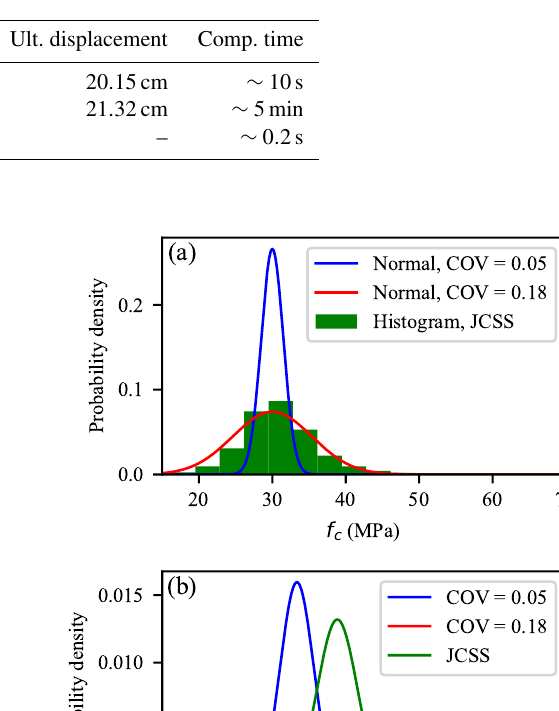
Table 2. Ultimate displacement, ultimate pressure and computation time provided by the three approaches considering quasi-static pushover test.